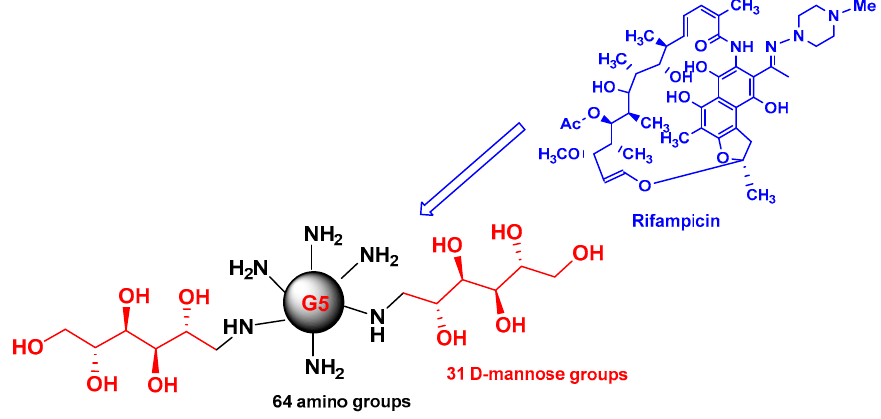
Figure 4. Schematic 2D of mannosylated G5 EDA-PPI dendrimer and RIF Me.